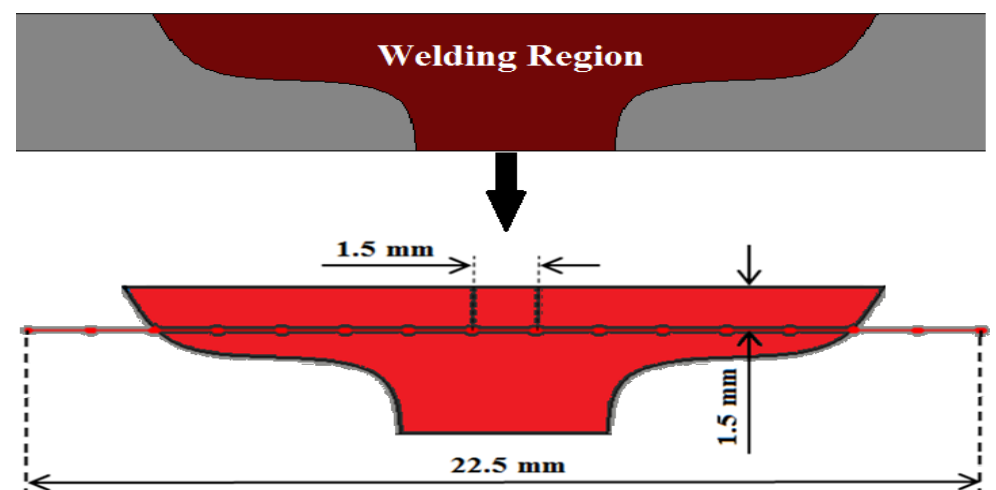
Figure 5. Position of points used for hardness measurement.